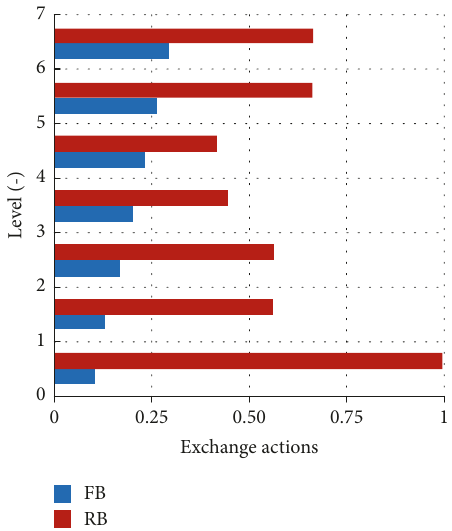
Figure 11: Exchange actions for the FB and RB